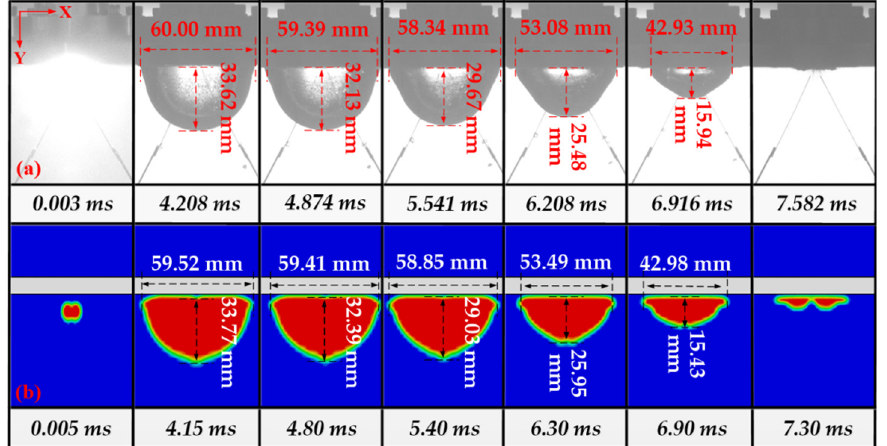
Figure 14. A pulsation chart of the first cycle of the bubble when γ = 0.33 and ζ = 0: ( a ) Electric spark bubbles generated by 400 V high-voltage electric discharge; ( b ) high-pressure cavitation bubbles simulated by ABAQUS/Explicit.